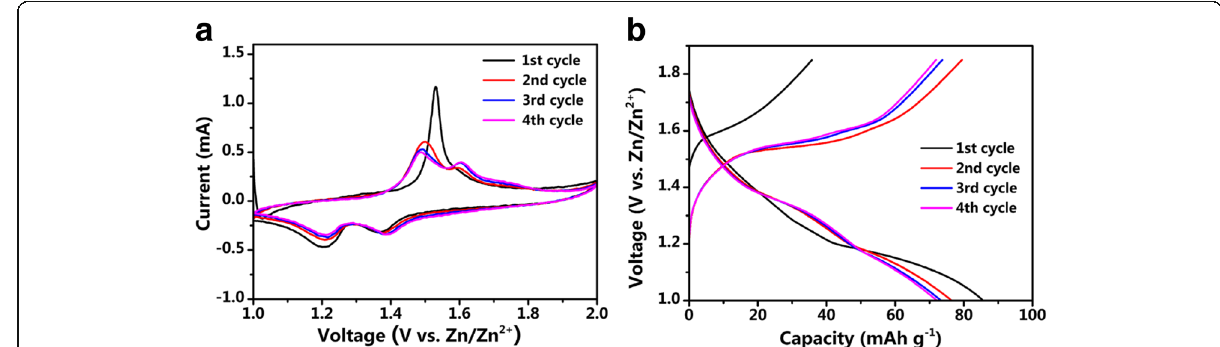
Fig. 4 Electrochemical performance of NMO/CNT electrode. (a) CV behavior of NMO/CNT electrode at a scan rate of 0.1 mV s − 1 . (b) Discharge/ charge voltage profiles of NMO/CNT electrode for the 1st, 2nd, 3rd, and 4th cycles at 4